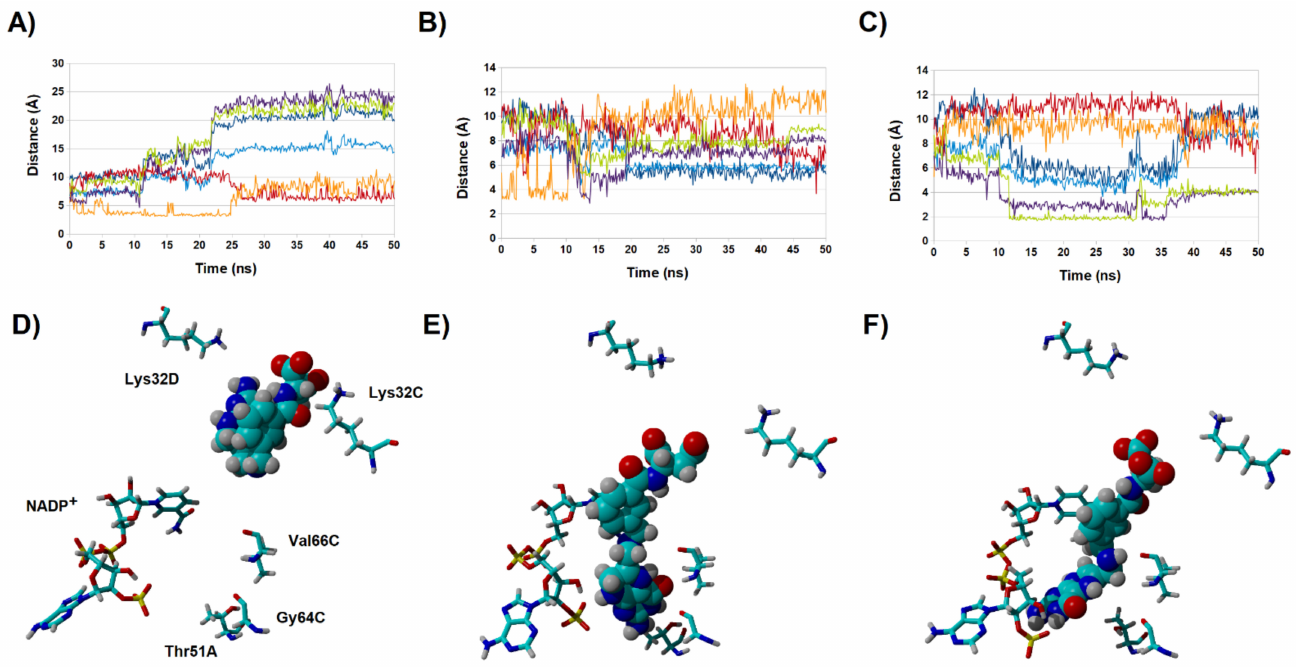
Figure 4. Evolution of key distances between N 5 -deprotonated dihydrofolate and R67 DHFR along multiple simulations ( A – C ). Dark orange: distance between 2 (cid:48) -phosphate and folate N 3 -H; violet: distance between Gly64 C=O and folate N 3 -H; light blue: distance between Val66 C=O and folate N 8 -H; dark blue: distance between nicotinamide C 4 and folate C 6 ; green: distance between Val66 NH and folate C=O; violet: distance between Thr51A C=O and folate NH 2 group. ( D – F ): the final poses obtained at the end of each 50 ns simulation. Most amino acids have been hidden for